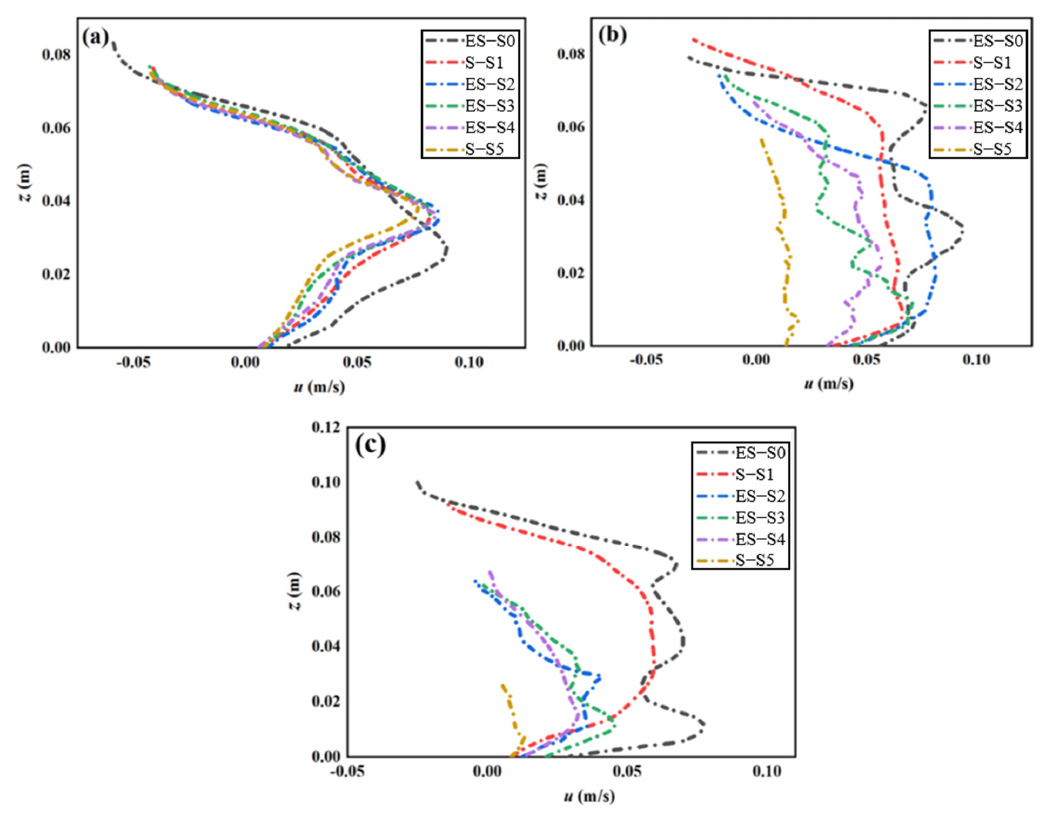
Figure 10. Comparison of the lateral averaged velocity profile in the thickest part of gravity current head (approximately 5 cm behind the current front) in the stratified environment: ( a ) the current front is at 8 cm before the vegetation region; ( b ) the current front is at 5 cm after the middle of the vegetation region; ( c ) the current front is at 7 cm after the vegetation region.